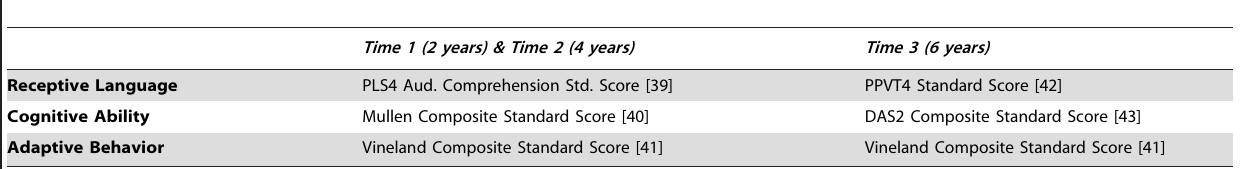
Table 2. Standardized measures of receptive language, cognitive ability, and adaptive behavior.